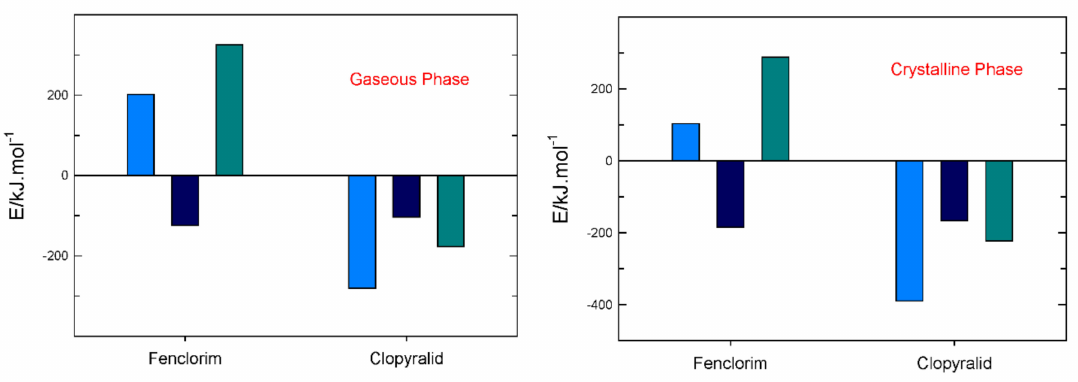
Figure 4. Relation between ∆